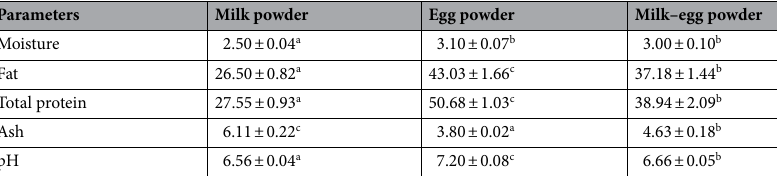
Table 2. Composition (g . 100 g −1 ) and acidity characteristics of raw milk powder, egg powder and milk– egg powder. a,b —different letters in the row denote statistically significant differences between the results (P < 0.05); ± means SD.